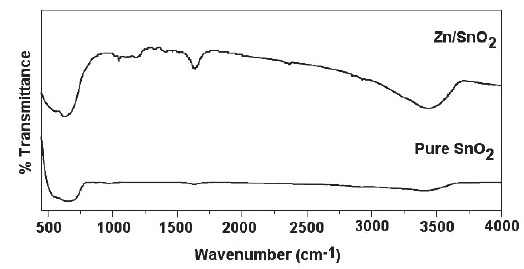
Fig.2. FTIR spectrum of pure and Zn-doped SnO2 nanoparticles